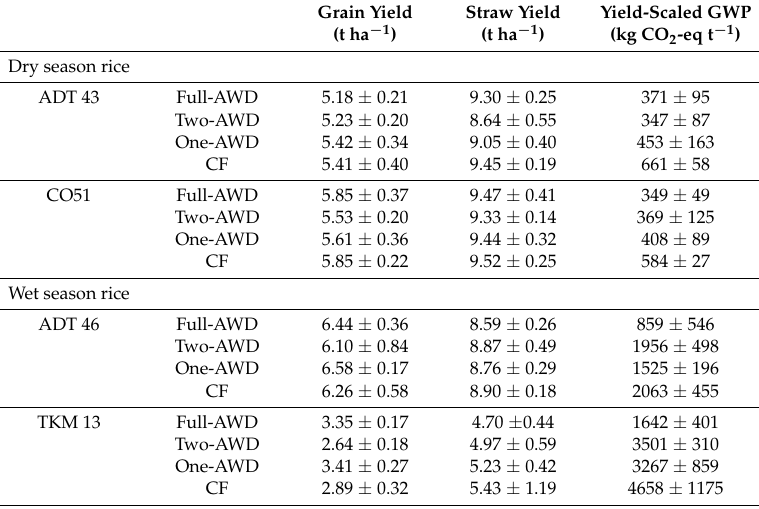
Table 2. Crop productivity and yield-scaled GWP from black gram and rice paddies as affected by different water management practices. Numbers in the table represent means ± standard